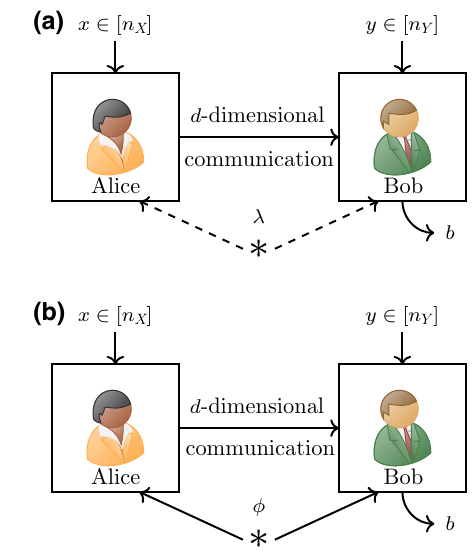
FIG. 1. The prepare-and-measure scenario. Alice encodes an input x into a physical system communicated to Bob. Bob mea- sures the incoming system depending on an input y and obtains an output b . We are interested in characterizing the possible con- ditional probabilities p ( b | x , y ) if the communication is limited to d -dimensional messages. Much of past research has considered the case (a) where Alice and Bob are initially independent or share classical randomness. We consider the situation (b) where they share quantum